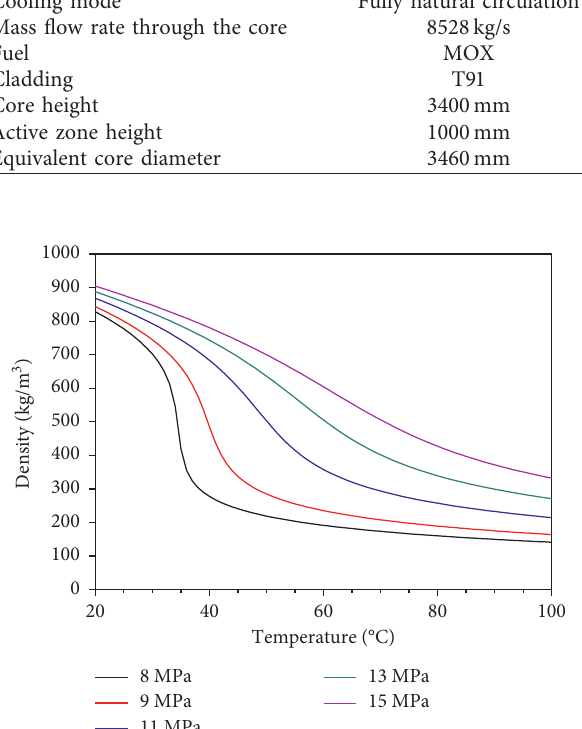
Figure 1: CO 2 density variation with temperature under super- critical